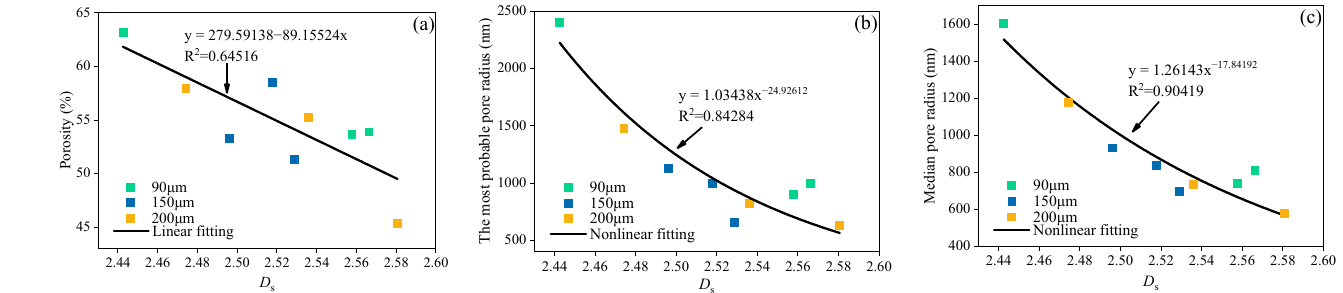
Figure 10. Relationship between D s and ( a ) porosity, ( b ) the most probable pore size, and ( c ) median pore radius of porous alumina samples with 70 vol.% pore-forming agents.